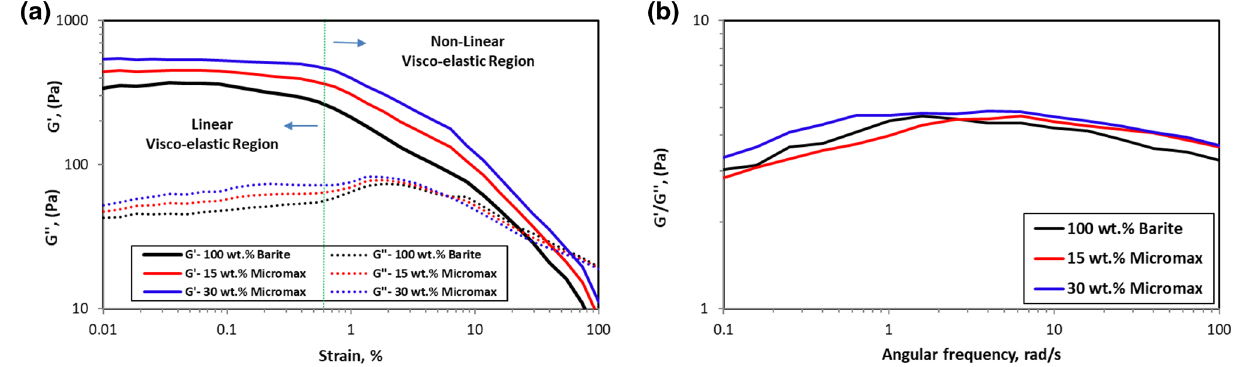
Fig. 8 Effect of Micromax additive on viscoelastic properties a amplitude sweep test and b frequency sweep test (350